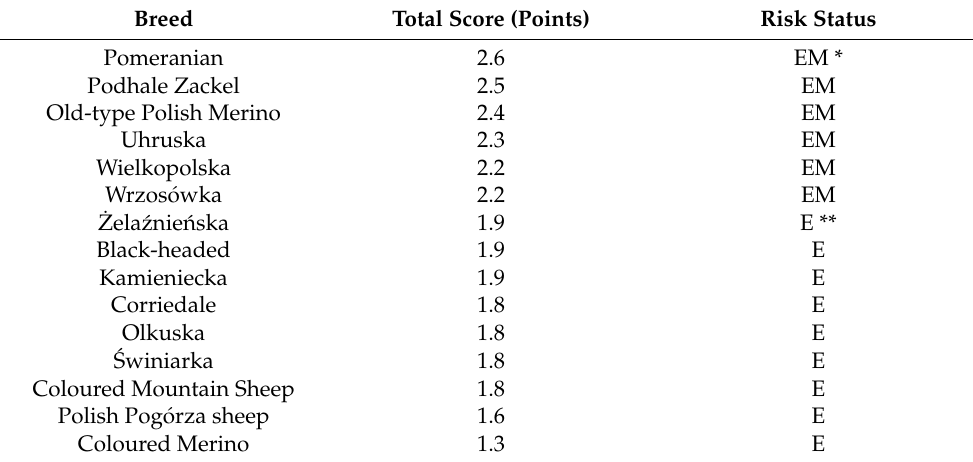
Table 3. Risk status of the Polish national breeds of sheep. Breed Total Score (Points) Risk Status 2.6